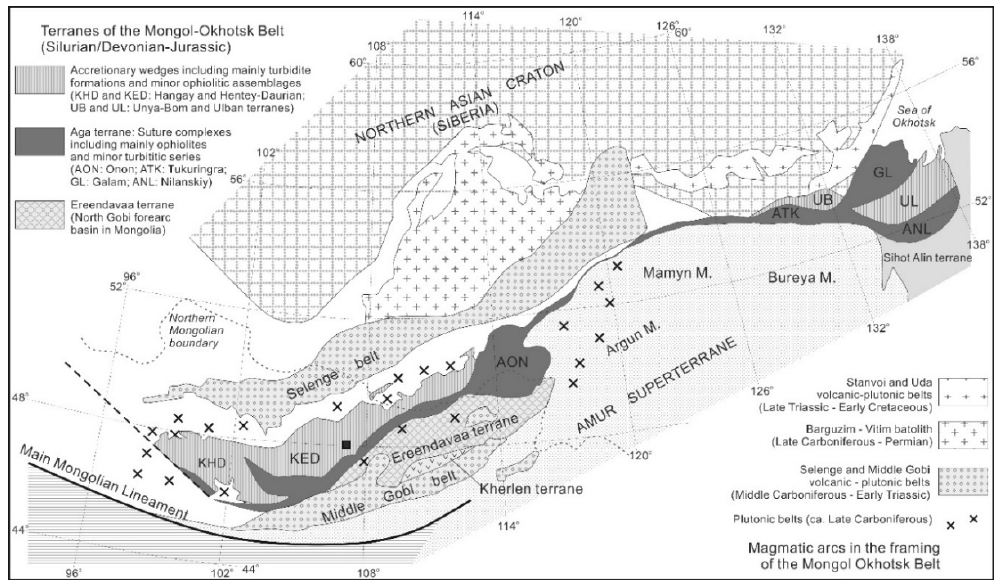
Figure 1. Sketch map showing the major tectonic units along the Mongol-Okhotsk belt (after [11]).